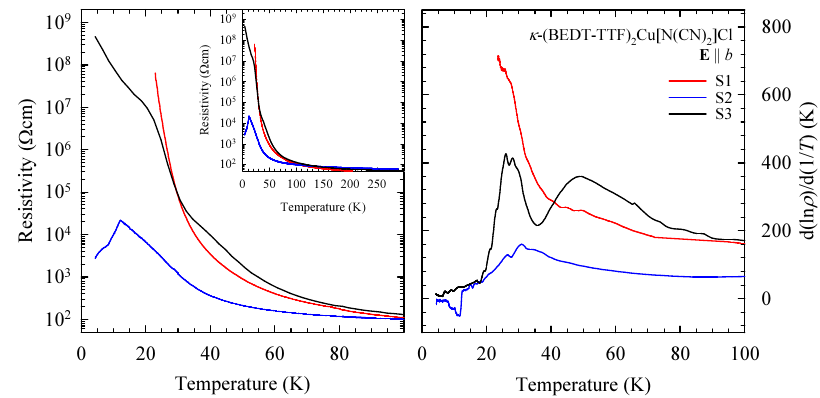
Figure 3. ( Left ) Distinct behaviors of the resistivity along the b axis below 100K for three single crystals of κ -Cl: S1 (red), S2 (blue) and S3 (black). Data for S3 are after [18]. The inset displays the resistivity behavior in the whole temperature range demonstrating a weak activated behavior similar for all three samples. ( Right ) Logarithmic resistivity derivative versus temperature.